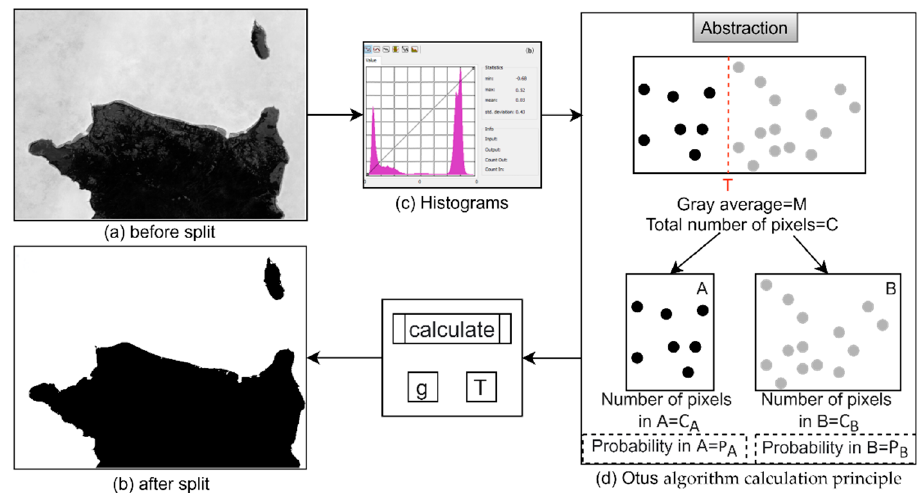
Figure 3. Threshold segmentation of normalized NDWI images. ( a ) the normalized NDWI image before split; ( b ) the normalized NDWI image after split; ( c ) histograms of the normalized NDWI image; and ( d ) schematic diagram of Otsu algorithm calculation principle.